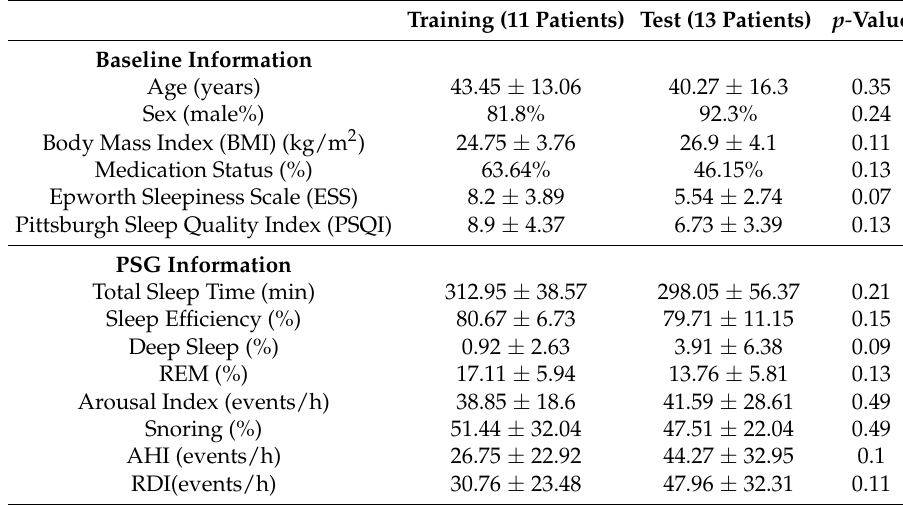
Table 1. Information of the studied subjects. Data are presented as the mean ± the standard deviation (SD). AHI, apnea hypopnea